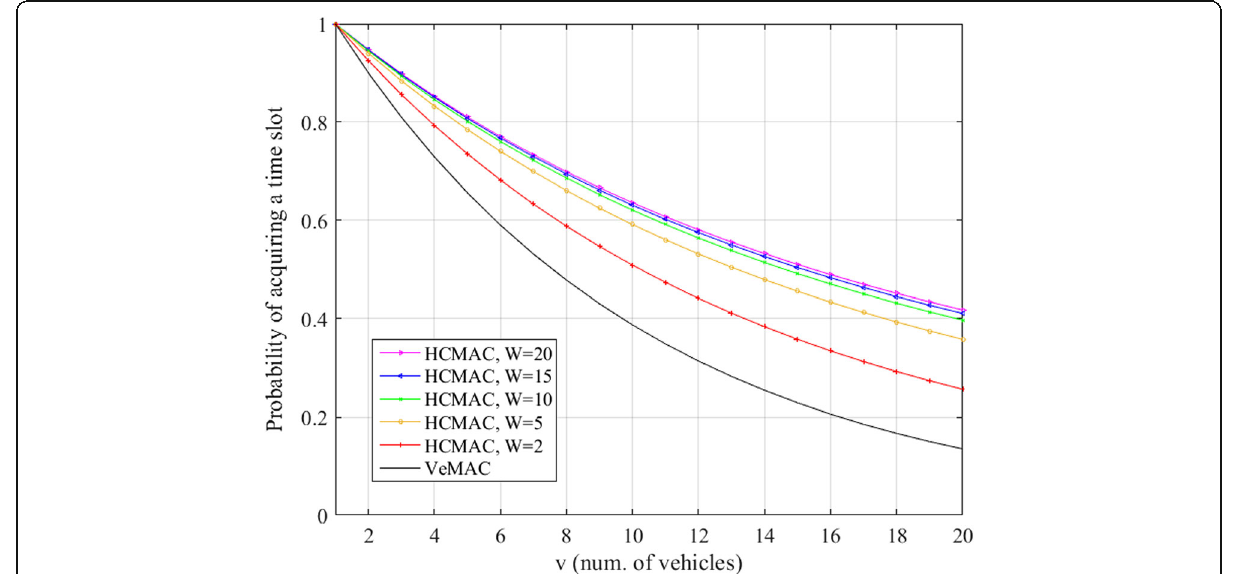
Fig. 13 The probability of acquiring a time slot (analytical results, S = 10, W = [2, 5, 10, 15,